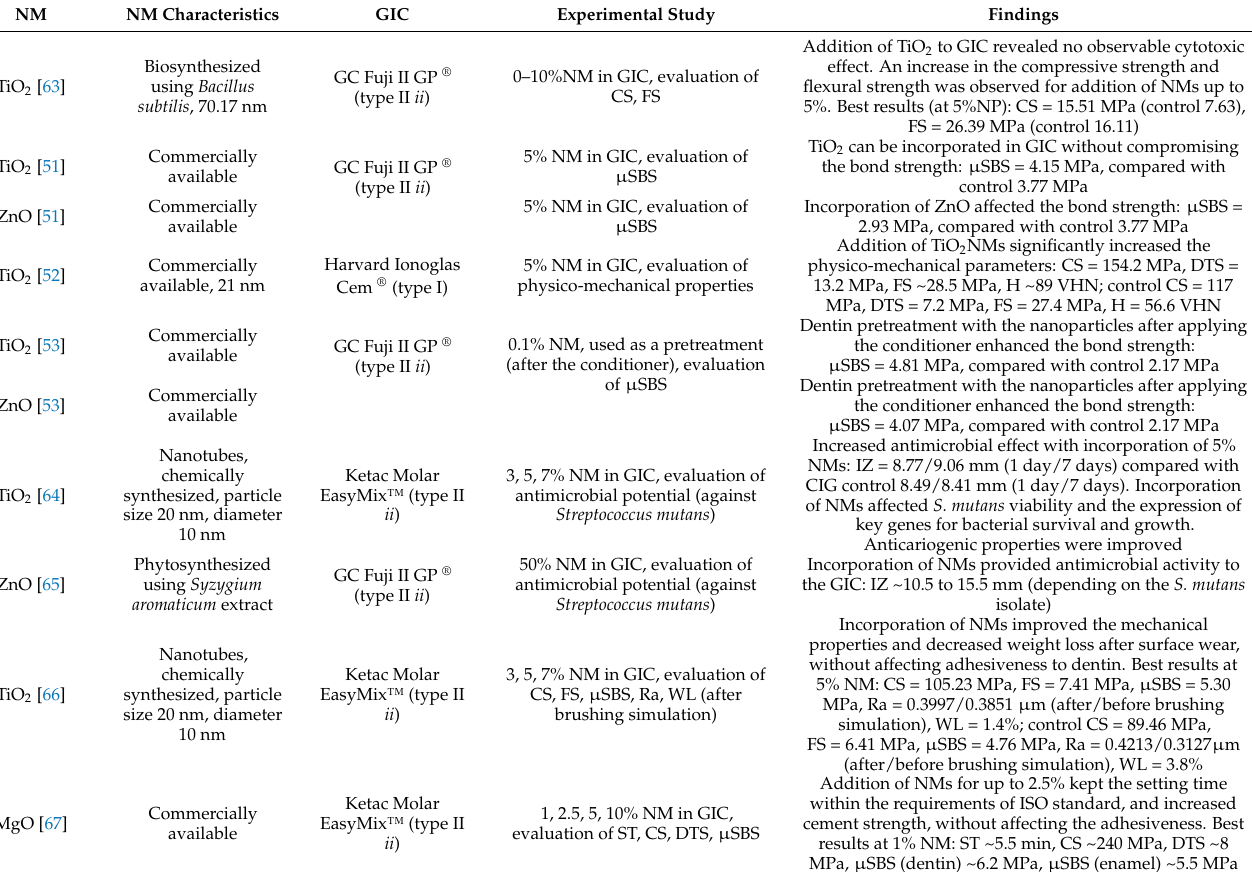
Table 4. Examples of metallic and metalloid oxide nanomaterials incorporation in GIC (references presented in chronological order) 1